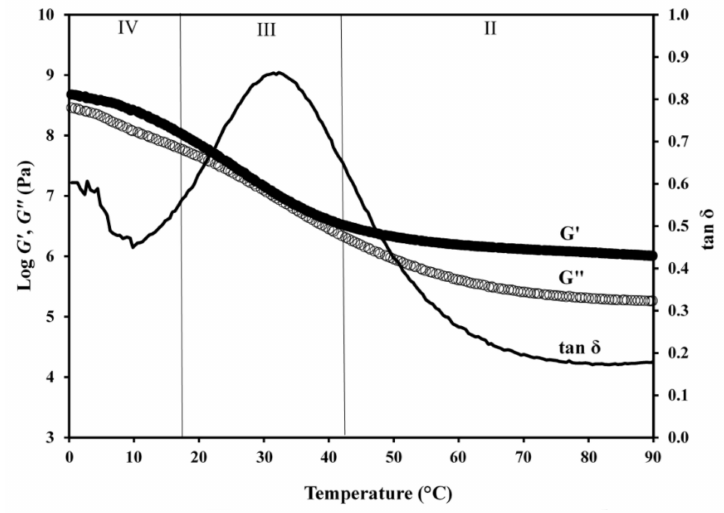
Figure 4. Master curve of G (cid:48) , G” and tan δ as a function of temperature for the HPMC-AAc network (1:5); scan rate 1 ◦ C min − 1 , frequency 1 rad s − 1